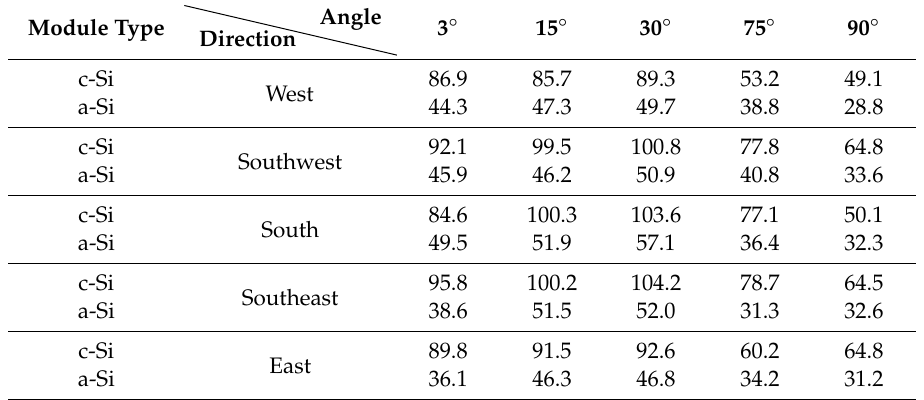
Table 7. Cumulative annual power generation (kWh / module) for di ff erent installation directions and angles. Module